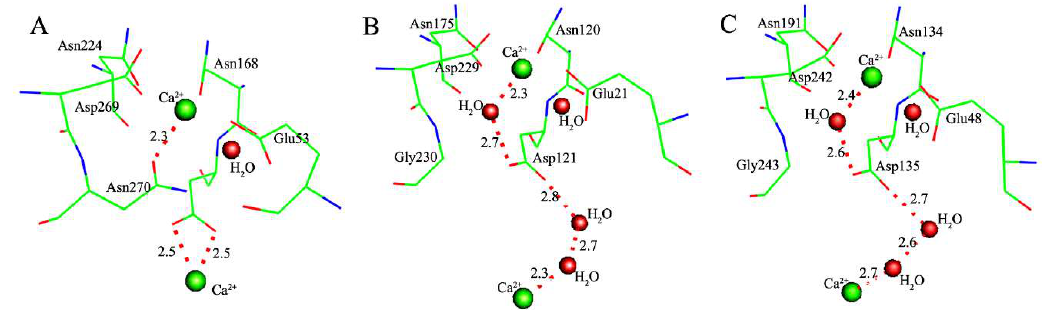
Figure 7. Structures of the catalytic Ca 2+ ion and the buried structural Ca 2+ ion in PON1 (PDB code: 3SRE) [15] ( A ), DFPase (PDB code: 2GVW) [18] ( B ), and XC5397 (PDB code: 3DR2) [28] ( C ), respectively. These figures are drawn by the PyMOL [44].